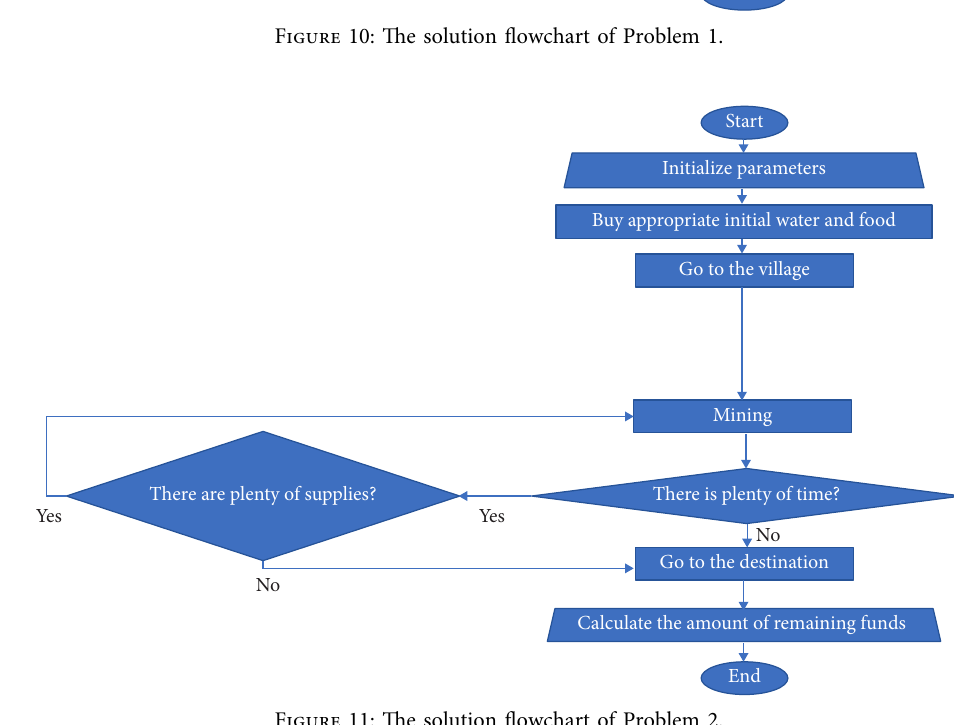
Figure 11: The solution flowchart of Problem